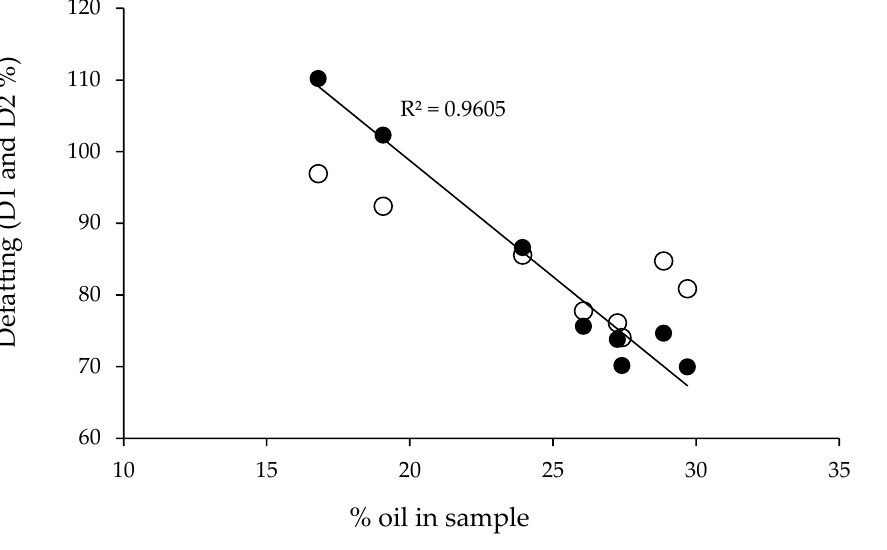
t i m e ( m i n ) Figure 2. Comparison of the defatting kinetic of H. illucens larvae at 450 bar and 60 °C: ( ) 270 cm 3 vessel and 100 g/min CO 2 ; ( ) 270 cm 3 vessel and 60 g/min CO 2 ; ( ) 1350 cm 3 vessel and 85 g/min CO 2 ; ( ) 1350 cm 3 vessel and 130 g/min CO 2 ; (- - -) trend line. Figure 3. Supercritical defatting attained D1 ( ) and D2 ( ) in different samples of H. illucens larvae as a function of the initial oil content (% w/w) of the flour. Solid line: D1 linear correlation. Extraction conditions (1350 cm 3 vessel): 450 bar, 60 °C, 450 g larvae, 130 g/min CO 2 , and 190 min.